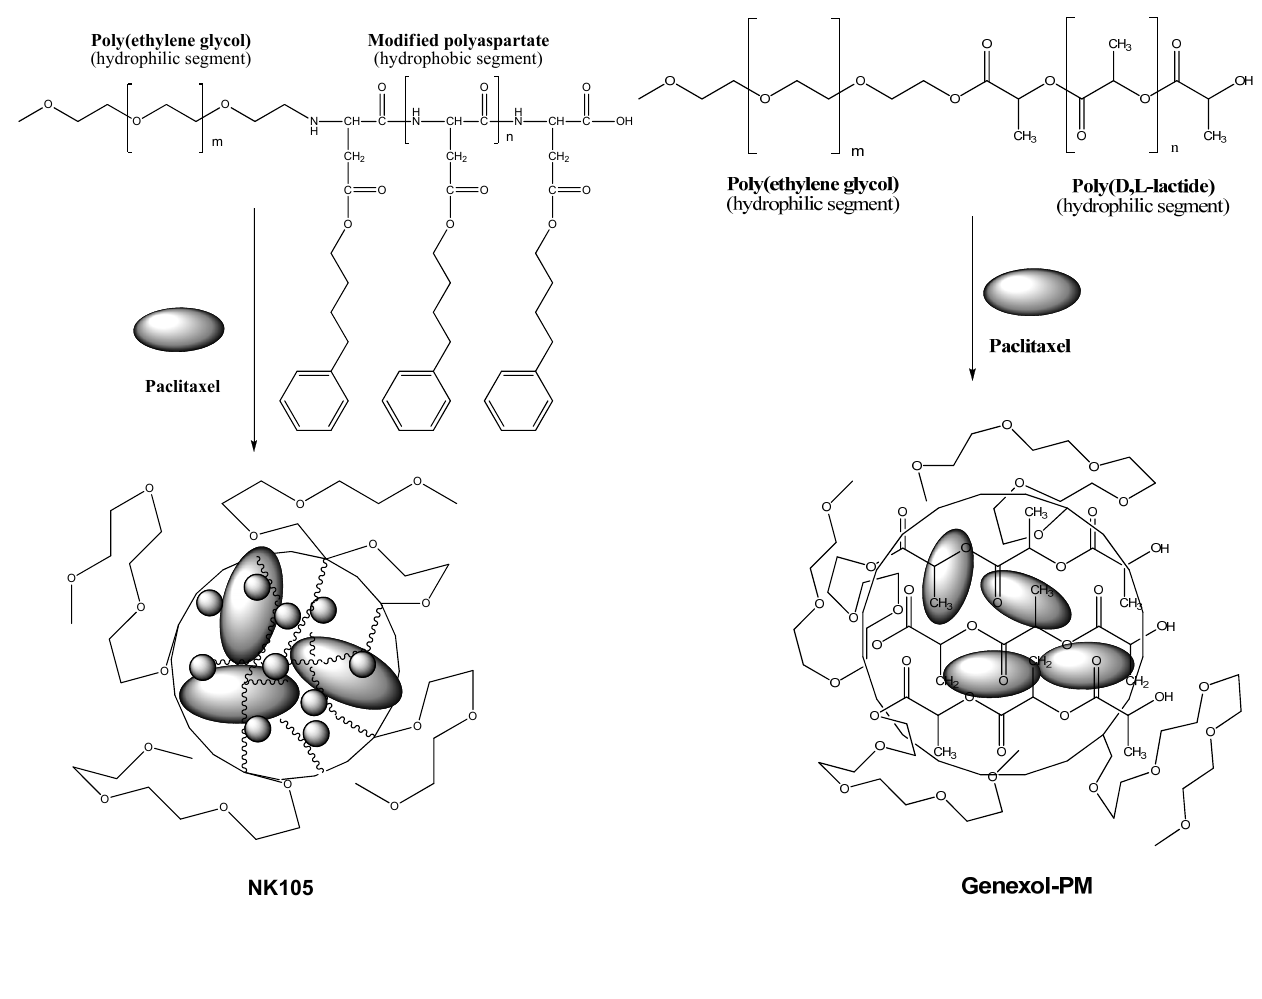
Figure 4. Schematic representation of NK105 and